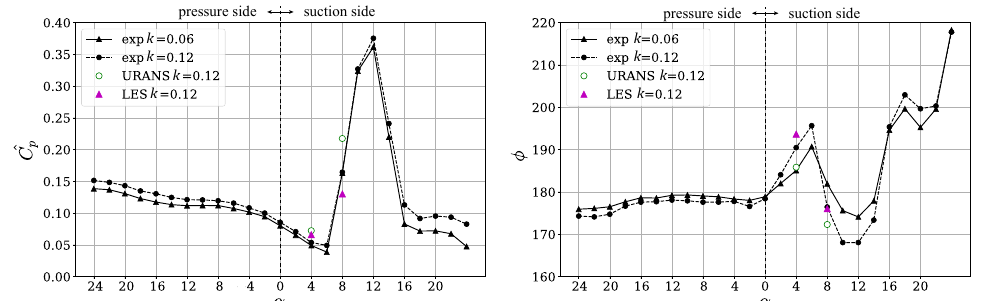
Figure 12. Variation of unsteady pressure amplitude and phase with incidence angle measured at 20% chord. Oscillation frequency k = 0.06 and k = 0.12.